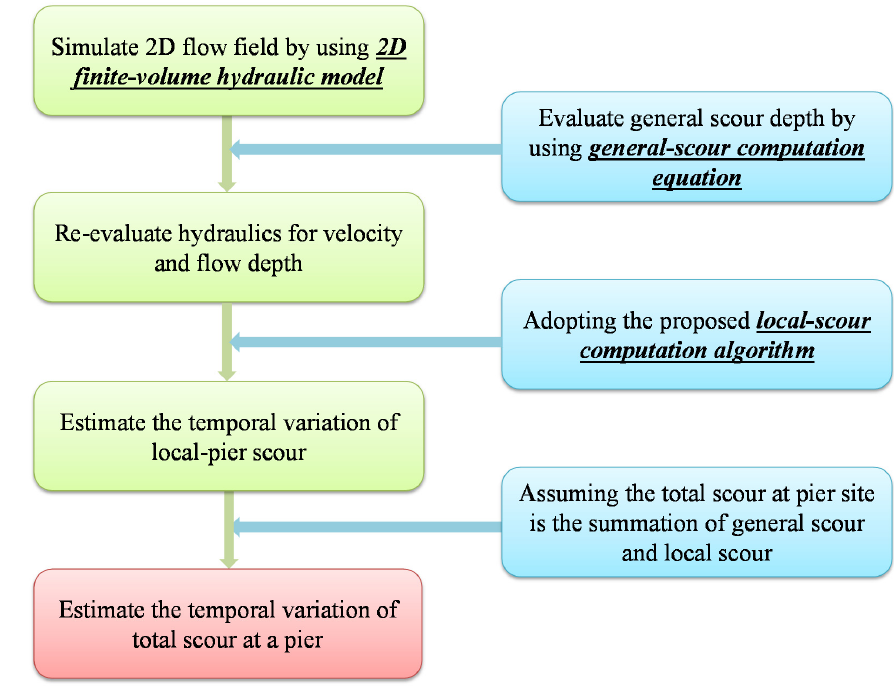
Figure 10. Flow chart of the proposed method for simulating total scour-depth evolution.